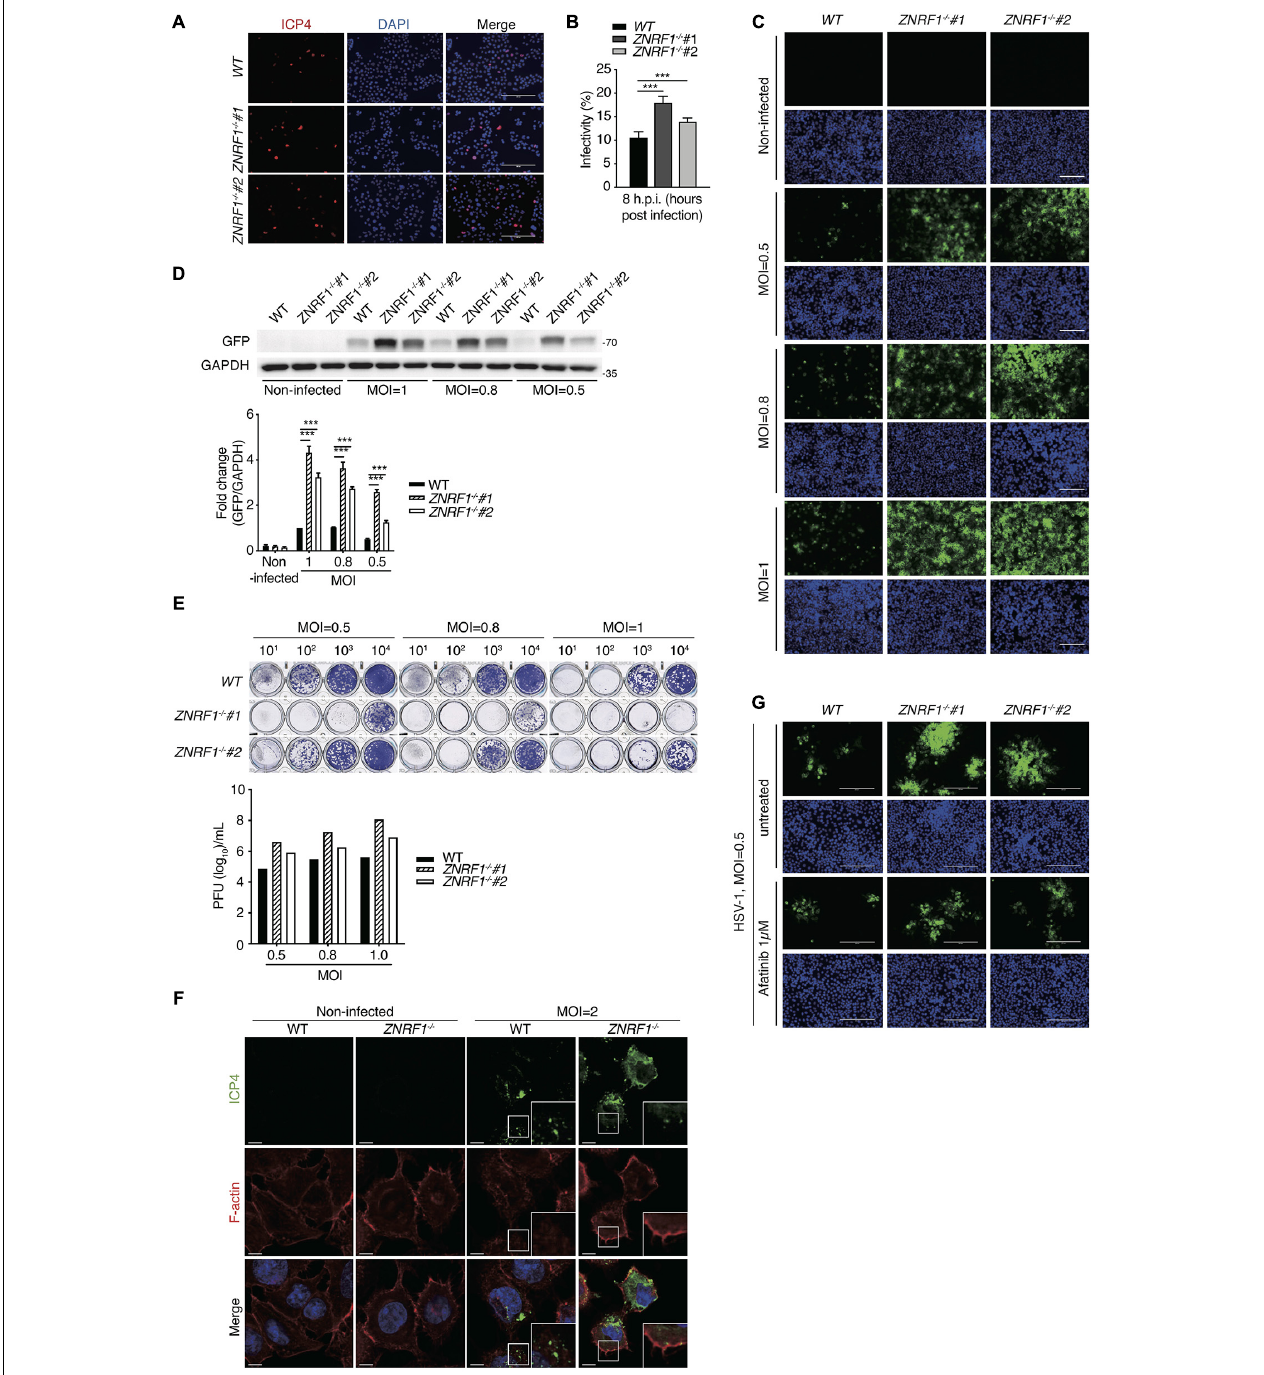
FIGURE 9 | ZNRF1 depletion enhances the entry of HSV-1 into A549 cells. (A) Wild type and ZNRF1 − / − A549 cells were infected with HSV-1 (MOI = 8) for 8 h. Cells were fixed and stained with anti-ICP4 antibody (red) and DAPI (blue). (B) HSV-1 infectivity in (A) was quantified by the percentage of ICP4-positive cells in five random microscopic fields. Scale bar, 200 µ m. *** P < 0.001. (C–E) Wild type and ZNRF1 − / − A549 cells were infected with GFP-expressing HSV-1 (MOI = 0.5, 0.8, or 1.0) for 48 h. (C) Cells were collected and analyzed by fluorescence microscopy. (D) Cell lysates were collected and subjected to immunoblotting using anti-GFP antibody. Quantification of immunoblotting analysis data of three independent experiments are shown in the lower panel. (E) The titers of HSV-1 in culture medium from (C) were determined by a plaque assay using Vero cells. (F) Wild type and ZNRF1 − / − A549 cells were infected with HSV-1 (MOI = 2) for 2 h. Cells were co-stained with ICP4 antibody (green) and filamentous actin (F-actin) (red). (G) WT and ZNRF1 − / − A549 cells were pretreated with 1 µ M Afatinib for 1 h and then infected with GFP-expressing HSV-1 (MOI = 0.5) for 48 h. Cells were collected and analyzed by fluorescence microscopy. Scale bar, 200 µ m. Results are presented as averages ± SEM. *** P < 0.001 (Student’s t -test). The data are representative of three independent experiments.